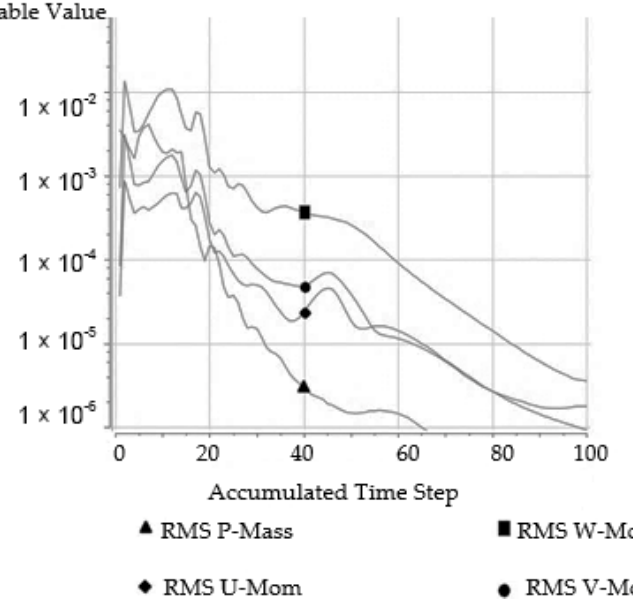
Figure 8. Convergence of results .